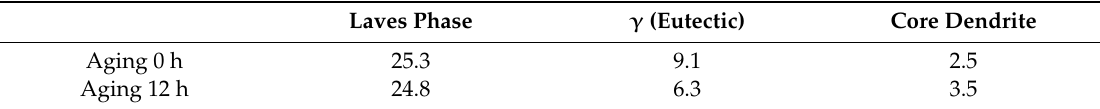
Table 4. EDS measurement of Nb in di ff erent locations